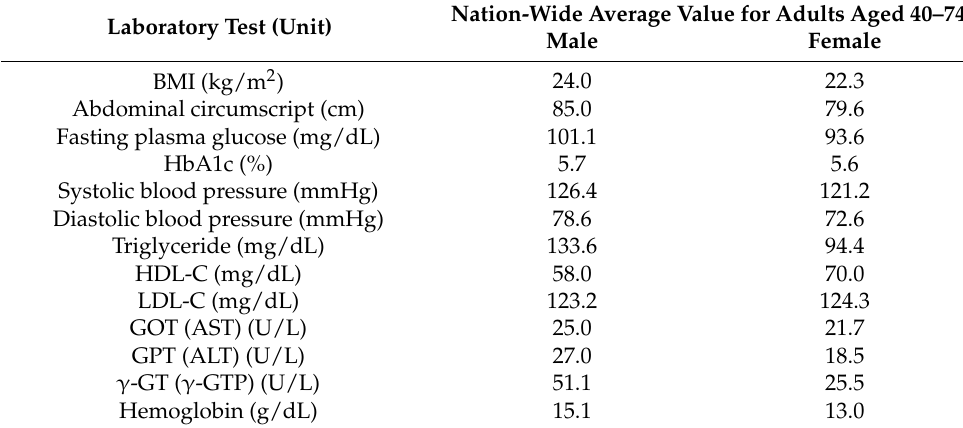
Table 1. Health checkup variables (laboratory tests).